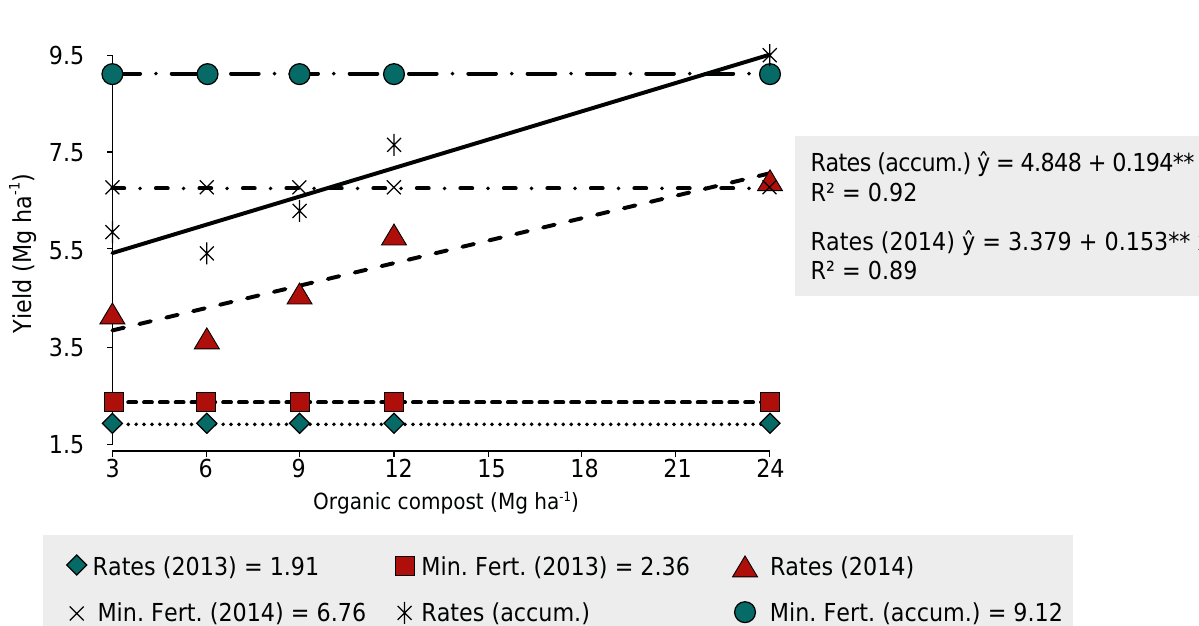
Figure 5. Corn yield as a function of application rates of organic compost. ** : significant at 1 % probability. Min. Fert.: Mineral Fertilizer; accum.: